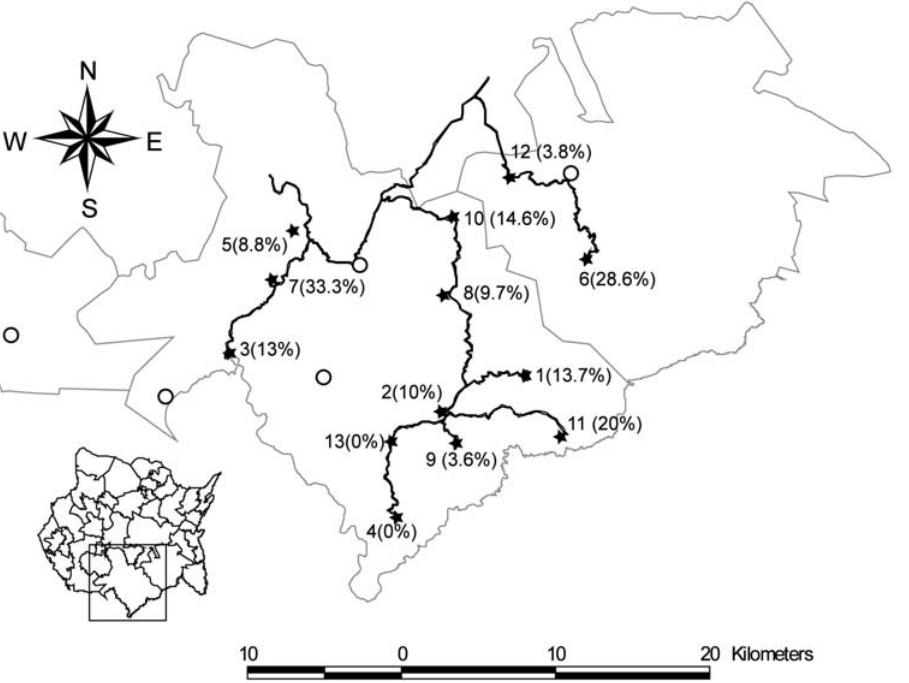
Figure 1. In the inferior left corner, a map illustrates the municipalities of the Mexican state of Morelos and the localization of the Sierra de Huautla. The main figure shows a map of the ‘‘Sierra de Huautla’’ displaying the studied villages marked by stars as well as their prevalence. Other villages in the region, marked by open circles, and main roads are shown. The distance bar applies to the largest map.